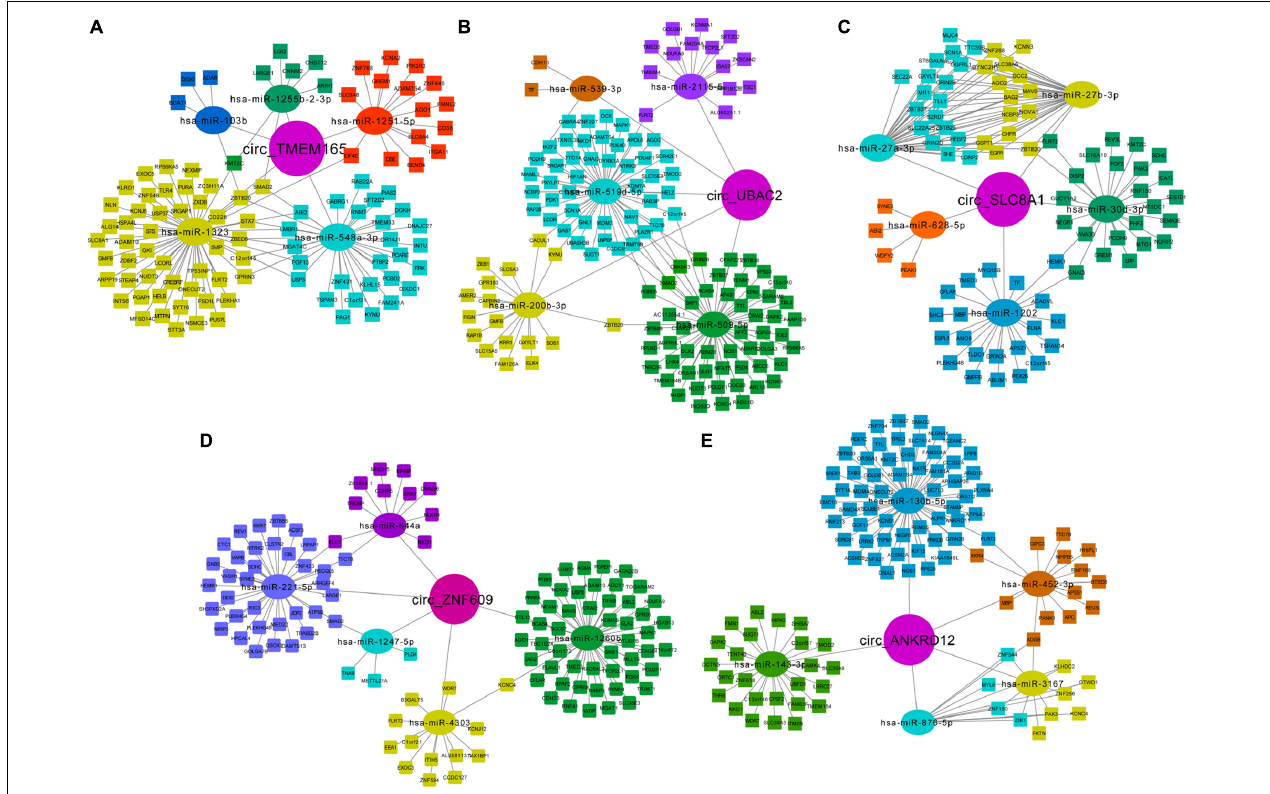
FIGURE 7 | Predicted network of circRNA-miRNA-mRNA. Predicted circRNA-miRNA-mRNA network for the five upregulated circRNAs in MI: (A) circ-TMEM165 (29), (B) circ-UBAC2 (31), (C) circ-SLC8A1, (D) circ-ZNF609, and (E) circ-ANKRD12. Circle represents circRNAs, oval represents miRNAs, and rectangle represents